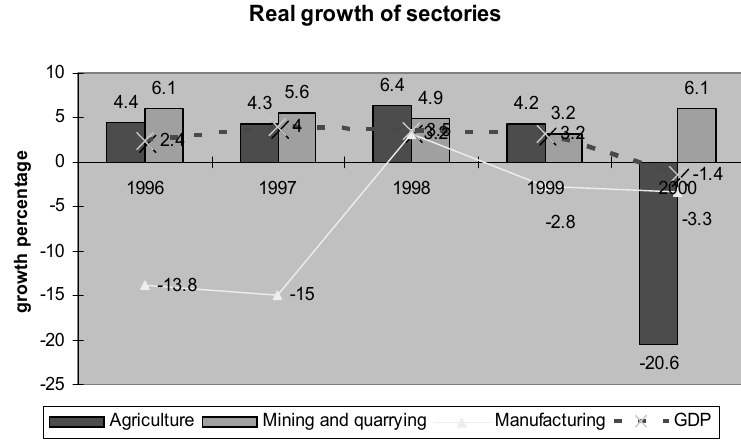
Fig. 1. Real growth by sectors Real growth of